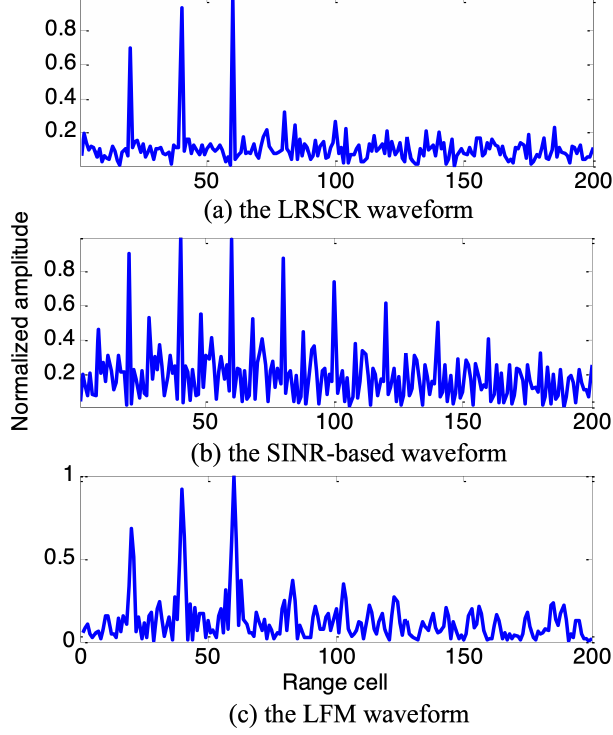
Figure 6. The range profile for considered